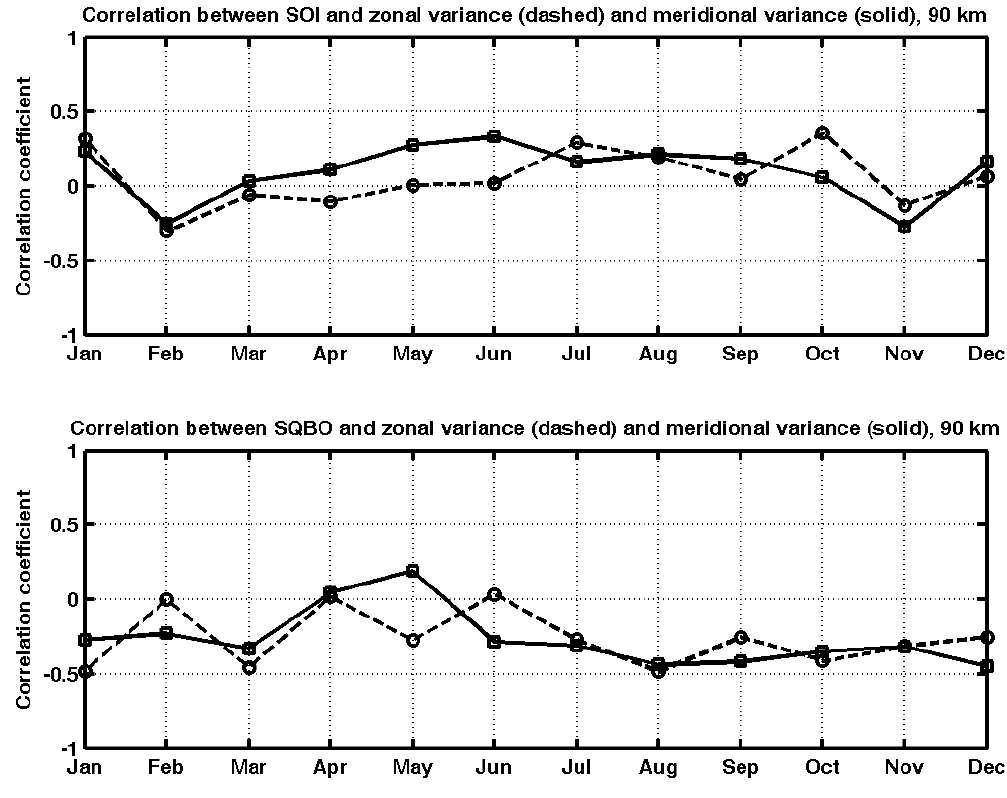
Fig. 5. Monthly variation of correlation coefficient between wind variances and southern oscillation (top panel) and stratospheric QBO (bottom